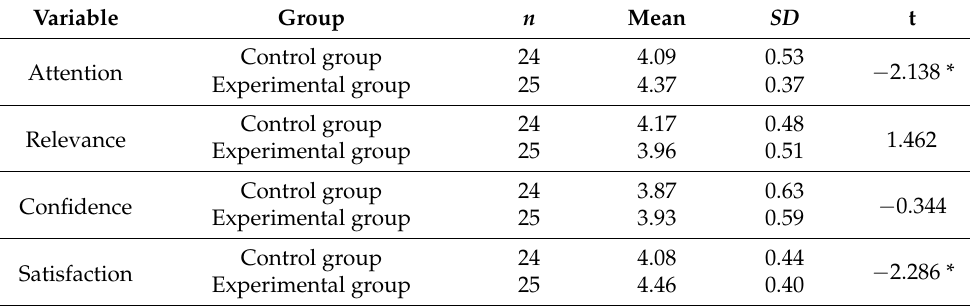
Table 2. t -test results of the four factors of learning motivation for the two groups.